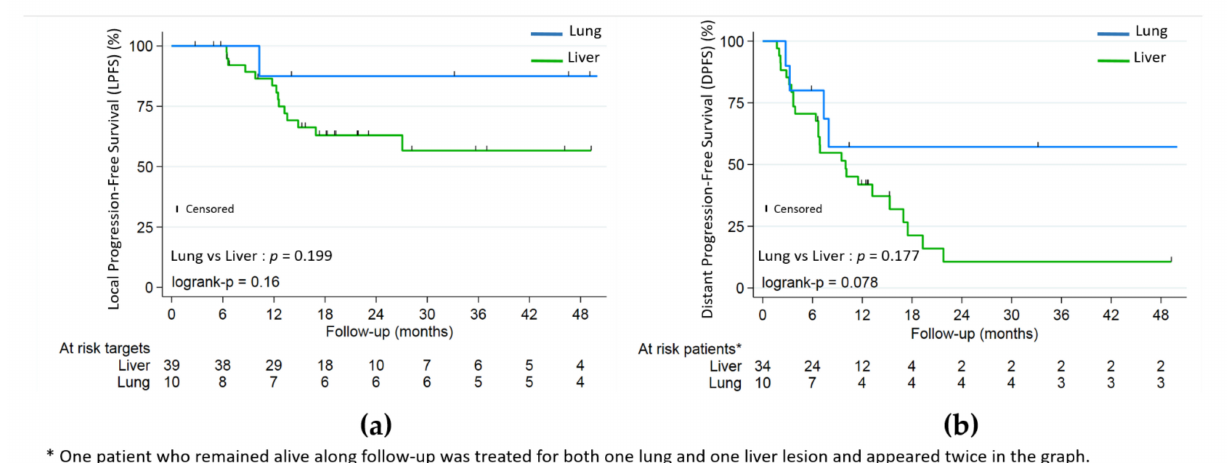
Figure 3. ( a ) Local progression-free (LPFS); ( b ) distant progression-free (DPFS) by lung and liver